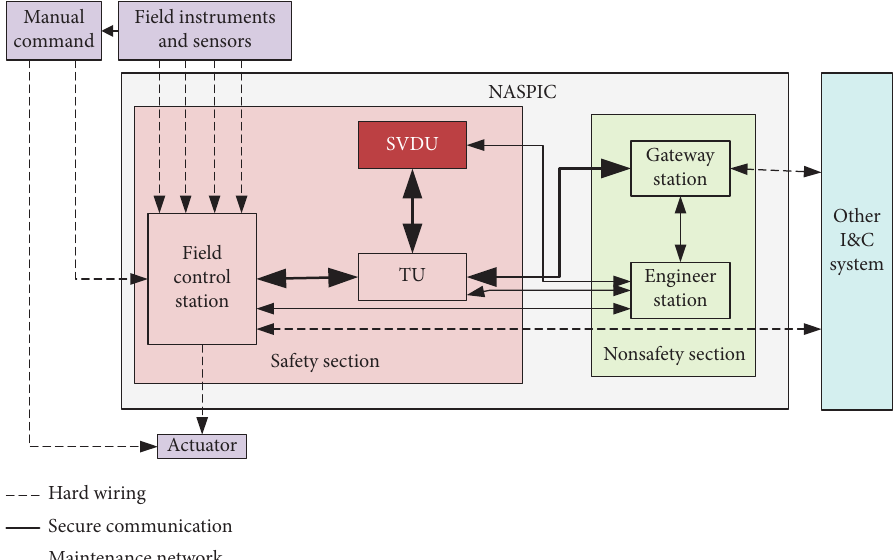
Figure 1: Composition relationship between SVDU and NASPIC platform.